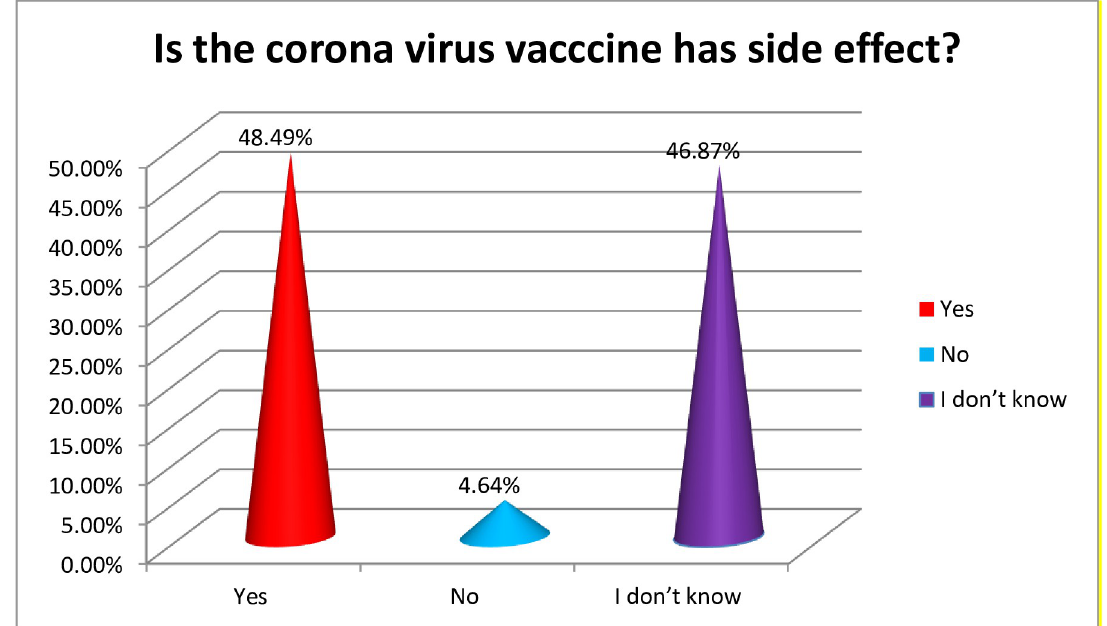
Fig 2. Perception the health care workers regarding Corona virus vaccine’s side effect, 2021.